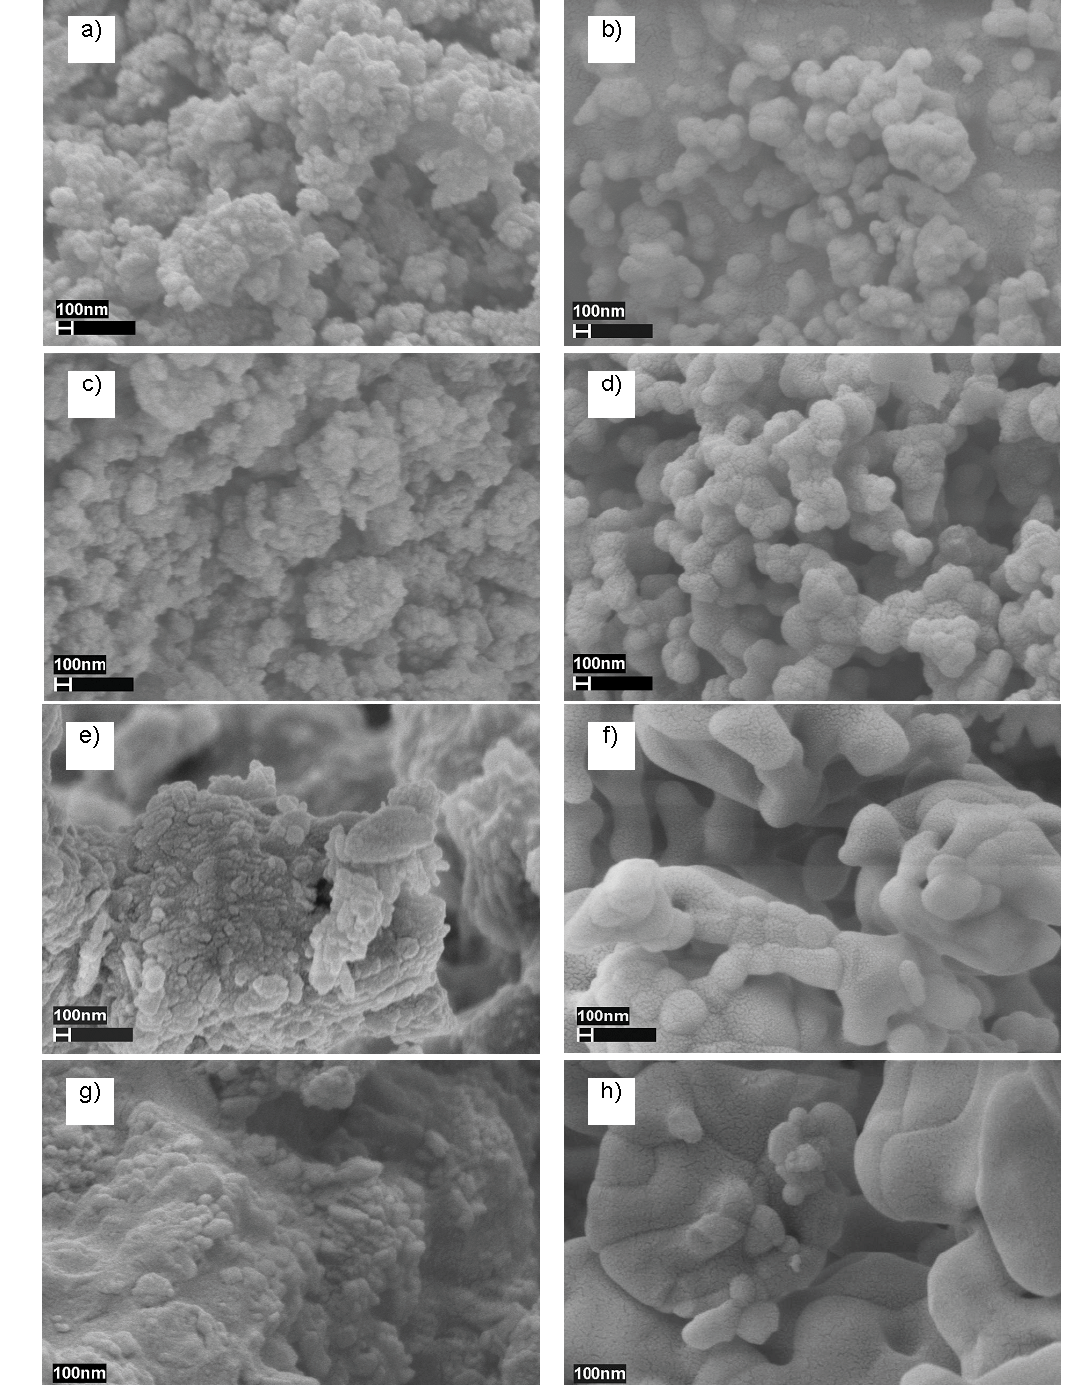
Figure 2. SEM micrographs of attrition ((a) EA,(b) EA_900,(c) SA,(d) SA_900) and ball ((e) EB ,(f) EB_900,(g) SB,(h) SB_900) milled